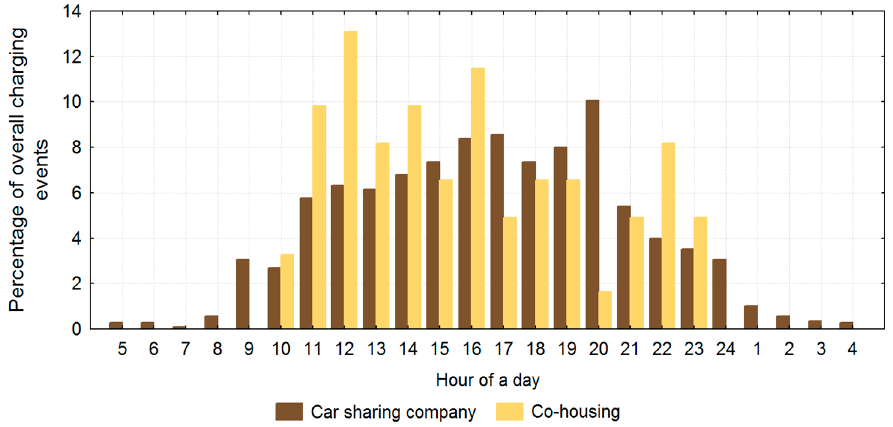
Figure 3. Driving behavior—distribution of trip lengths.